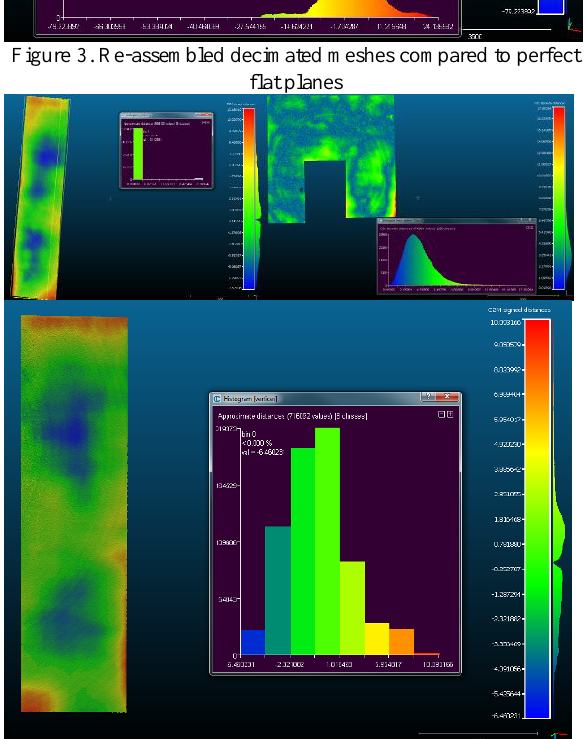
Figure 4. Re-assembled decimated meshes compared to perfect flat plane 4.4 Verticality check.